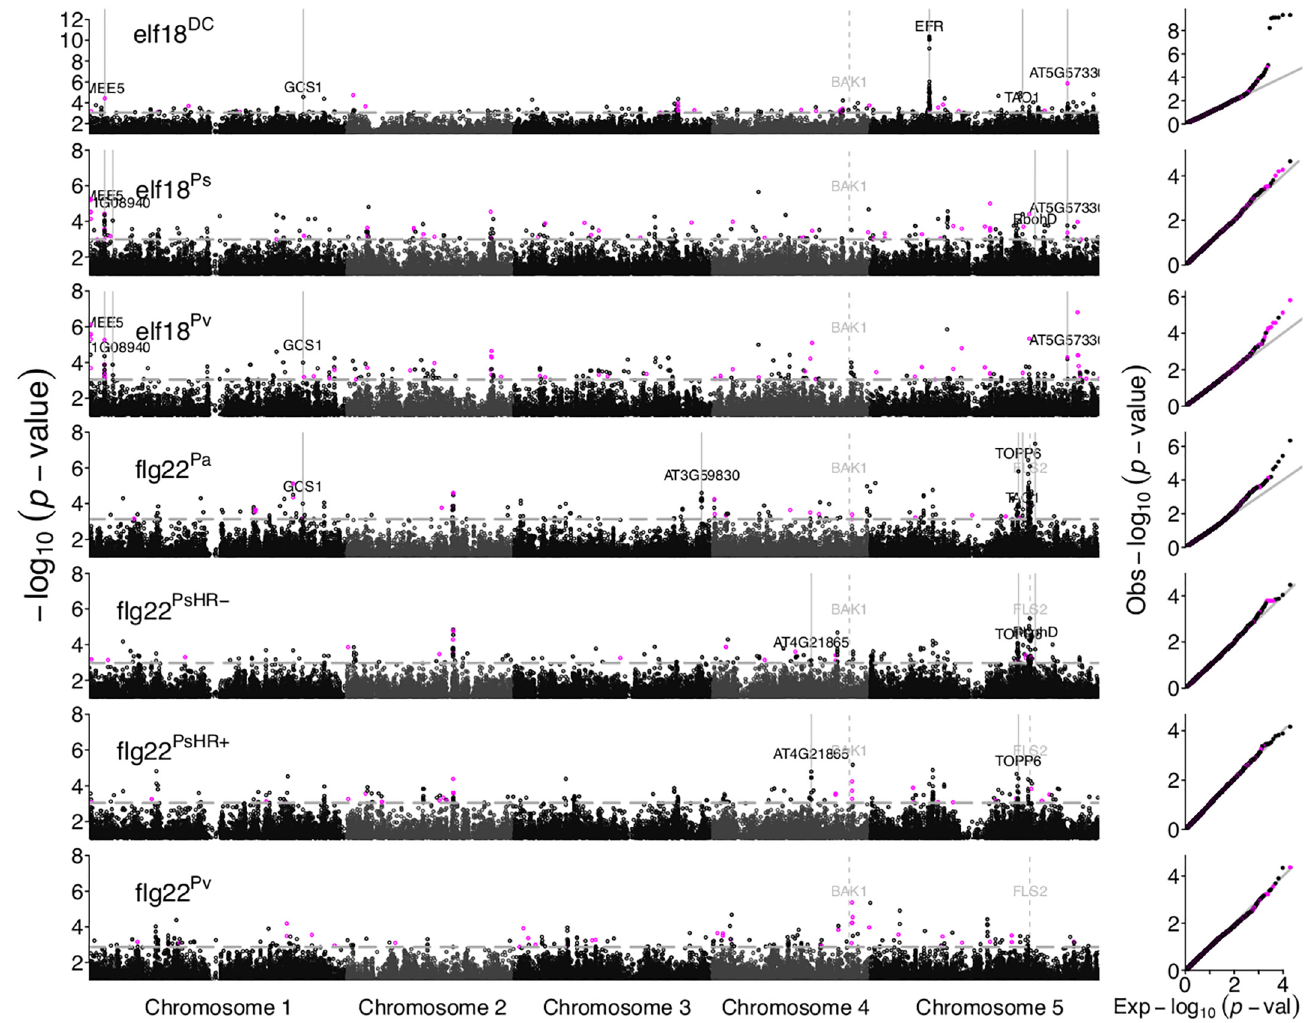
Fig 3. Manhattan plots of the GWA mapping for SGI induced by seven MAMP variants. The genome-wide distribution of the -log10 p -values of the SNP — phenotype associations are plotted as a function of the genomic position along the five chromosomes. The GWA study was conducted using EMMAX, which controls for population structure. The x -axis displays the position along the chromosome while the y -axis displays the p -value from a linear mixed model regression associating a given SNP with SGI. SNPs with minor allele frequency (MAF) < 0.05 were excluded. For clarity, only SNPs characterized by -log10( p -value) (cid:1) 1 are shown. The horizontal dashed line depicts the threshold for the 0.1% tail of the p -value distribution, which varies between peptide variants (flg22 Pv : 0.00134 to elf18 DC : 0.00088). SNPs that displayed above-threshold p -values were considered for further analysis. SNPs corresponding to rare alleles (0.05 > MAF > 0.1) are plotted in magenta. The right-most panel shows quantile plots of the expected versus observed p -values for each MAMP variant. Note the different scale of the y-axis of the uppermost panel. Genes that could be validated as underlying the natural variation in SGI are indicated in black. The a priori candidate genes FLS2 and BAK1 are not significantly associated with SGI but are indicated in gray for reference. A table with all genes underlying the different peak regions is available in the data folder of the repository